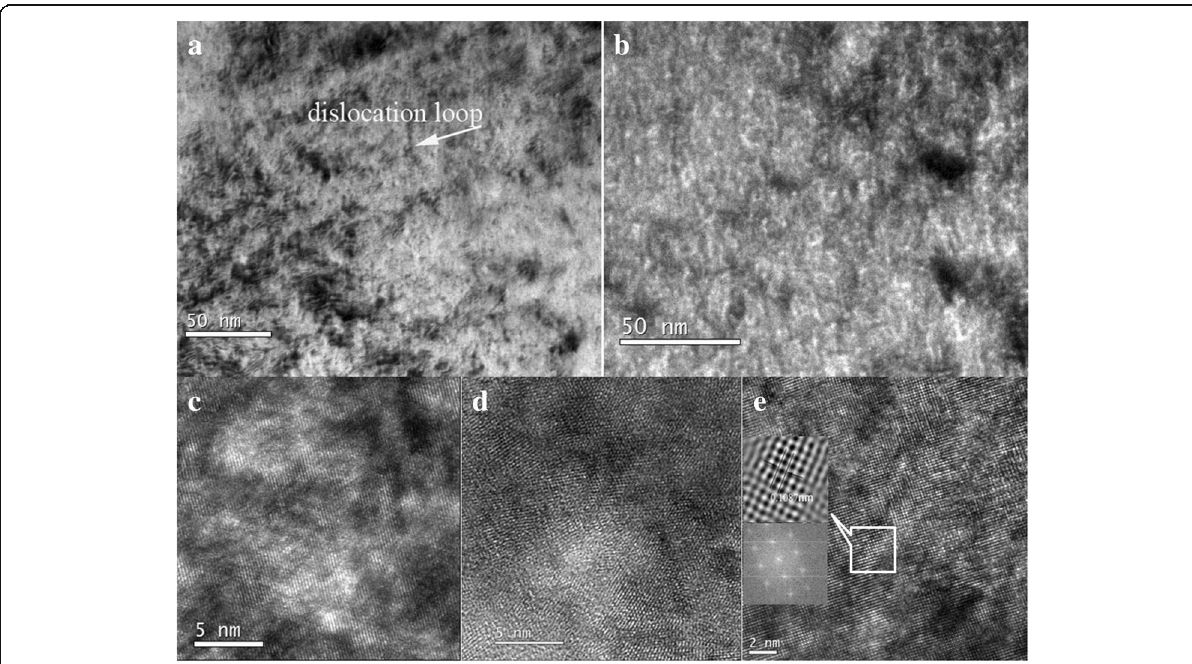
Fig. 2 Dislocation loops and bubbles of V-4Cr-4Ti alloys after post-irradiation annealing treatment at 450 °C for 10 h. a Dislocation loops. b Bub- bles of bright field. c , d , e Bubbles of high-resolution